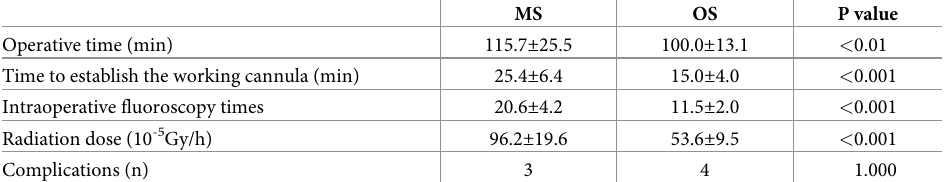
Table 2. Perioperative indicators.